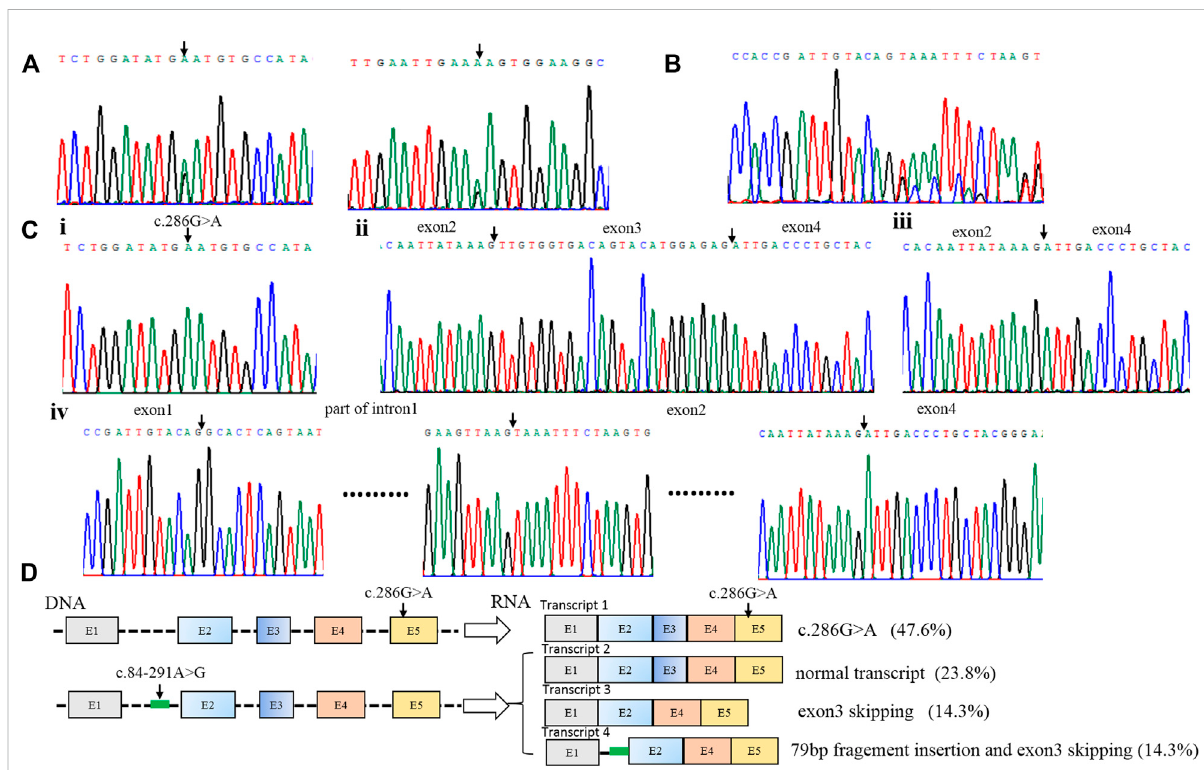
FIGURE 1 Identi fi cation of compound heterozygous variants of PTS in patient 1. (A) Sequence analysis of genomic DNA with compound heterozygous variants [c.286G > A (p.D96N) and c.84 – 291A > G] from patient 1. (B) RNA analysis of patient 1 by RT-PCR. (C) Four forms of the RNA product by T-clone: i. transcript 1 includes a missense variant (c.286G > A); ii. transcript 2 is the normal transcript, including all exons; iii. transcript 3 has exon 3 skipping; iv. transcript 4 includes the 79 bp pseudo-exon and exon 3 skipping. (D) Schematic map of the compound heterozygous variants